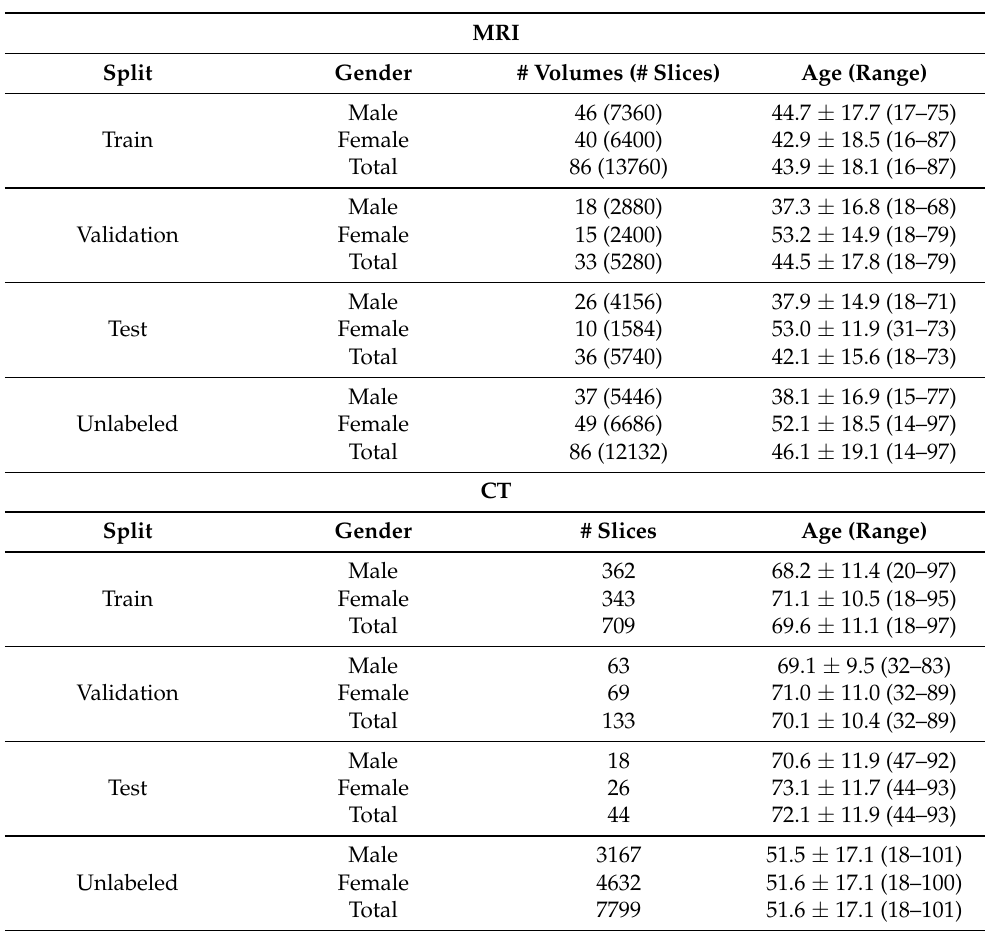
Table 1. Demographics of the subjects included in this study. Age is shown as mean ± standard deviation. For the CT dataset, one subject did not have age information and four subjects did not have gender information. MRI Split Gender # Volumes (# Slices) Age